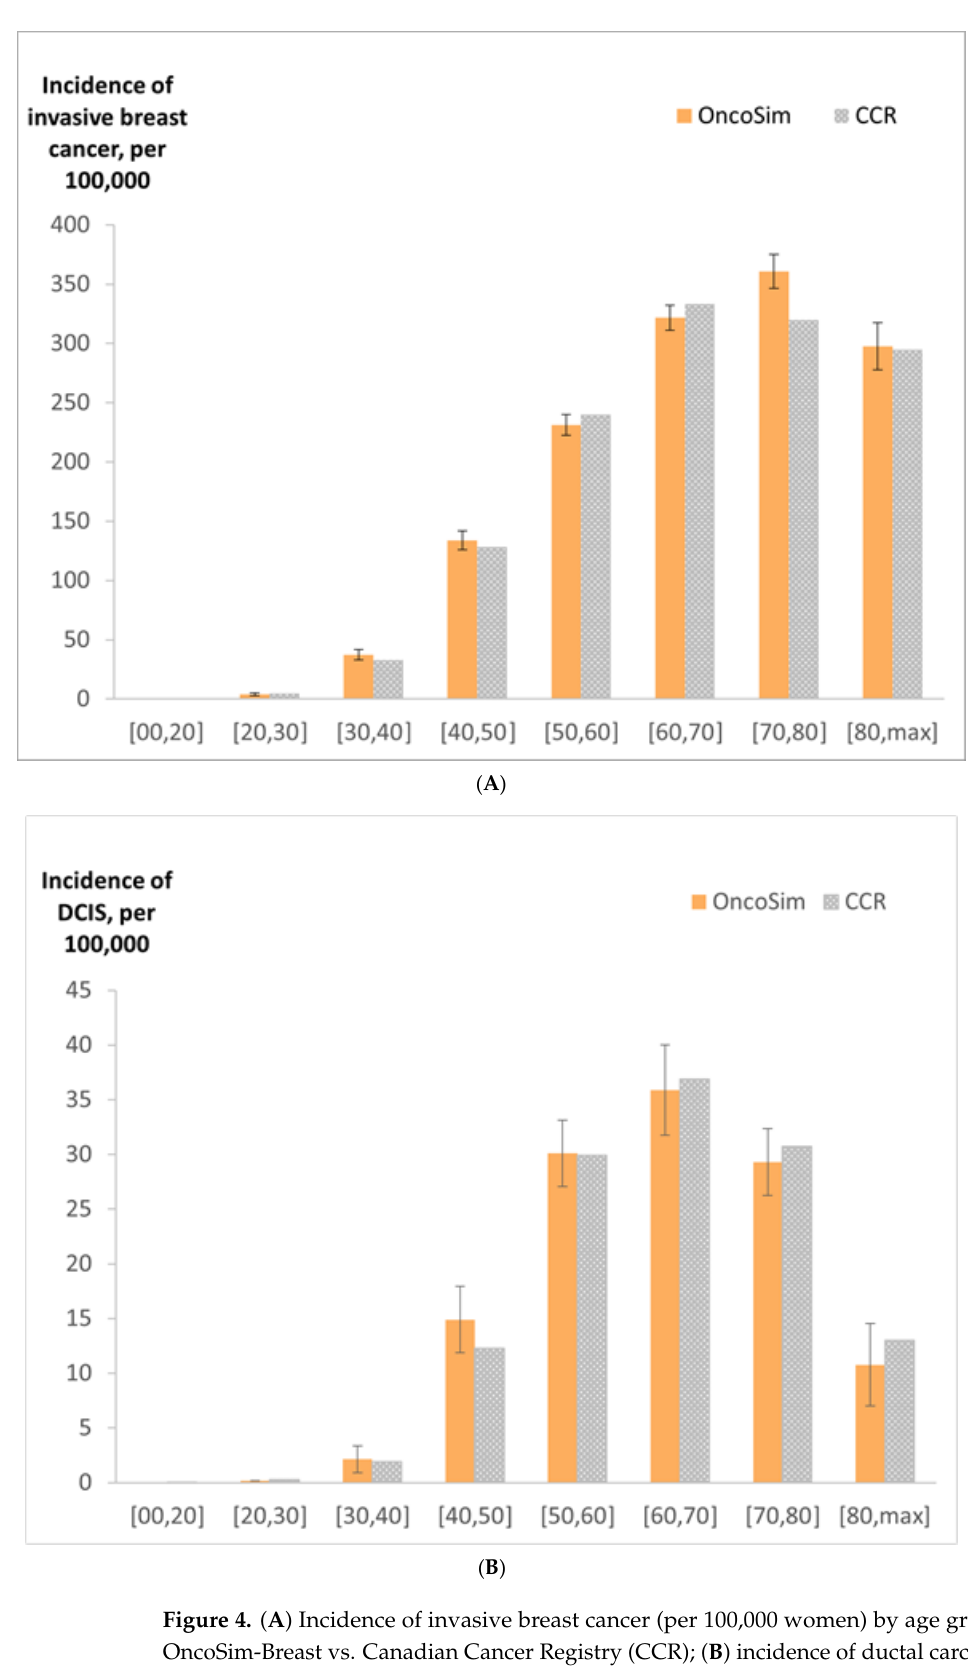
Figure 3. Incidence of invasive breast cancer (per 100,000 women), average per year (2008 – 2017), by province, OncoSim-Breast vs. Canadian Cancer Registry (CCR). * Data from Quebec were available only in 2008 – 2010 in the Canadian Cancer Registry because Quebec switched to a different cancer reporting system after 2010. Error bars represent the 95% confidence intervals.